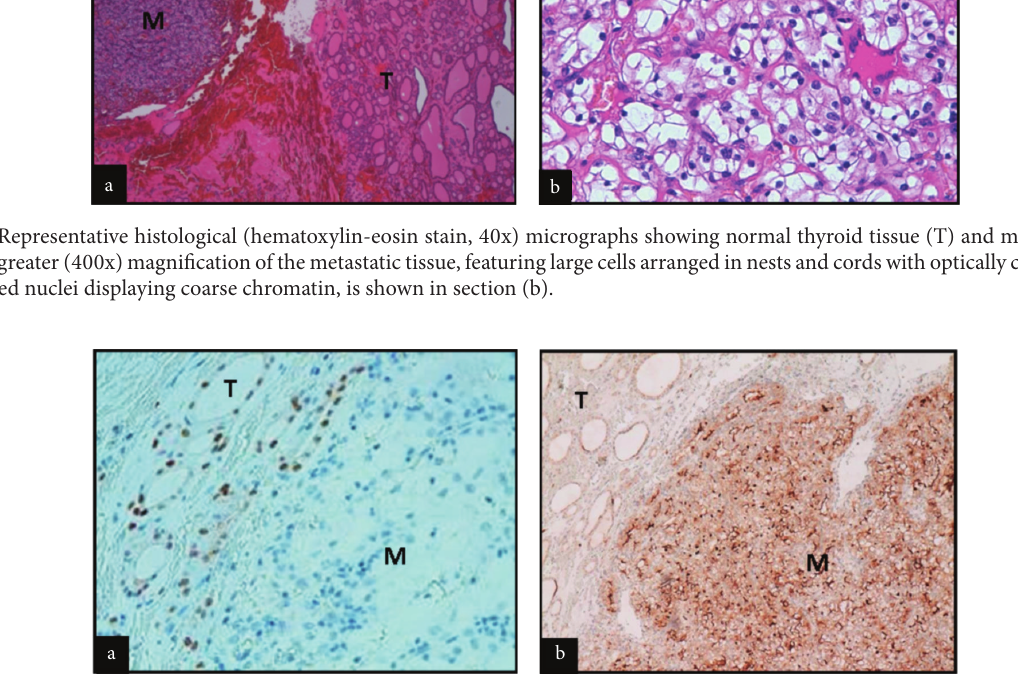
Figure 4: Thyroid transcription factor-1 (TTF-1) immunohistochemistry (100x) shows nuclear expression in the thyroid tissue (T) but not in the metastatic tissue (M) (a) and CD10 expression (40x) in the cell membrane of the metastatic tissue (M) but not in the thyroid tissue (T)